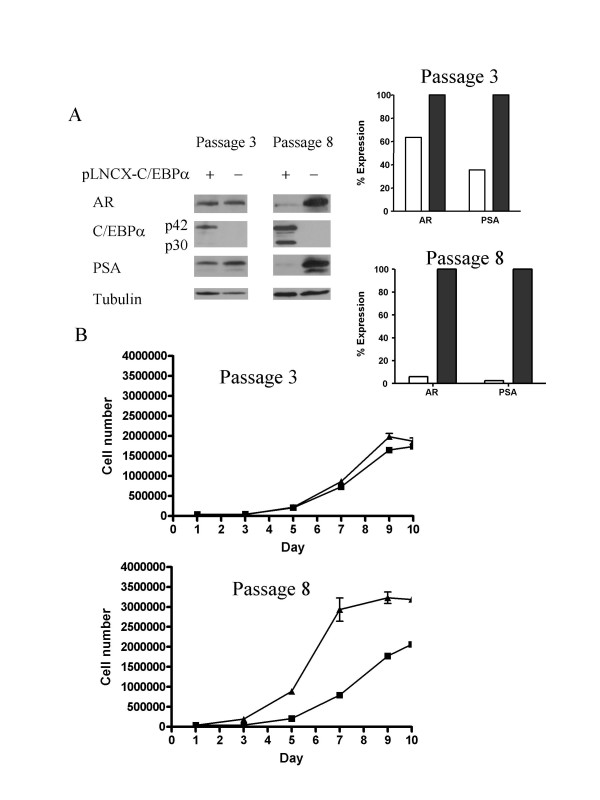
Down-regulation of the expression of AR and PSA after expression of C/EBPα in LNCaP cells. A. As described in the Methods whole cell extracts were obtained from LNCaP clone 2 cells at passage 3 and passage 8 and from corresponding control cells, subjected to SDS-PAGE and western blot analysis for AR, PSA, C/EBPα, and β-tubulin. The two right panels show the relative expression of AR and PSA at passage 3 and passage 8 after densitometry analysis of the western blot was standardized to β-tubulin expression. The open bars represent the Clone 2 cells expressing C/EBPα and the dark bars, the corresponding control LNCaP cells transduced with vector alone. B. As described in Methods growth curves were obtained for Clone 2 LNCaP cells transduced by retrovirus carrying C/EBPα (■) and control virus (▲) at passage 3 and passage 8.